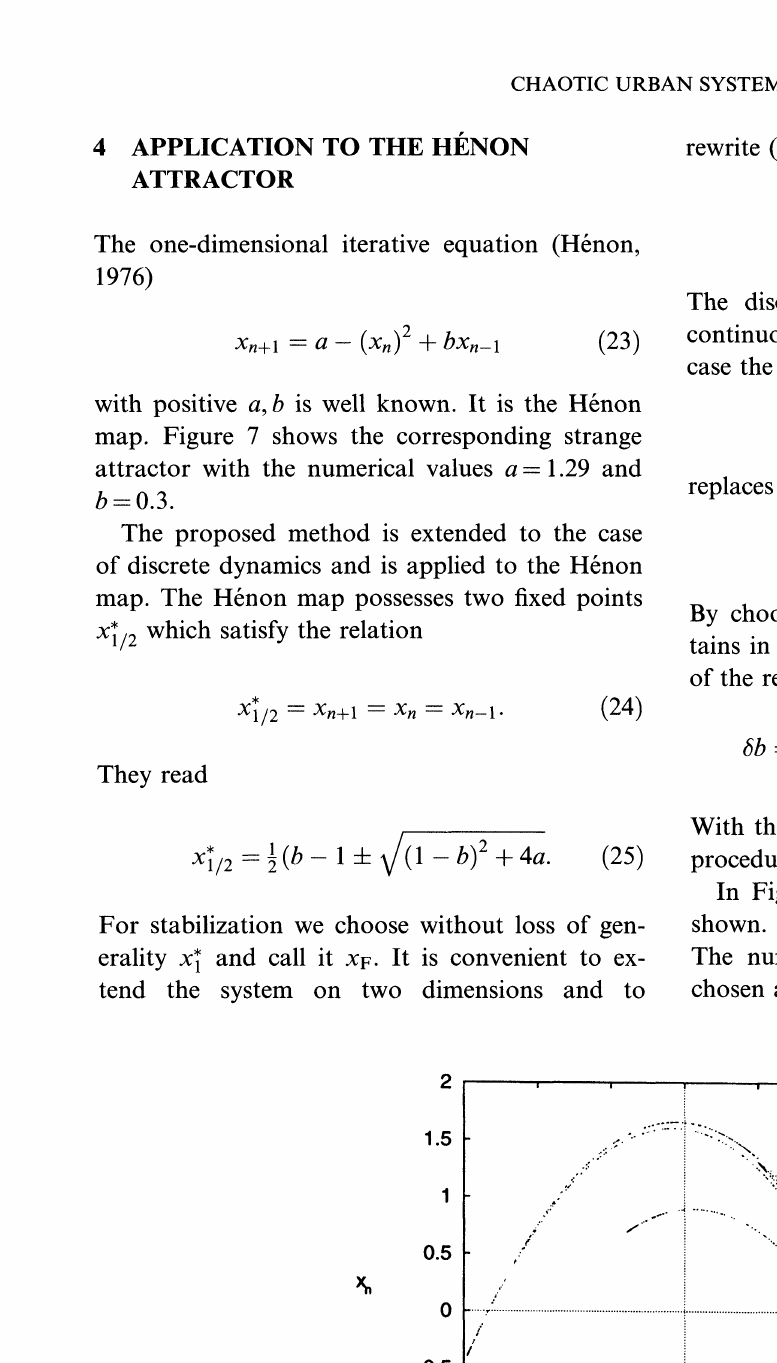
FIGURE 7 The H6non attractor in two-dimensional mapping. One of the fixed points (x v) is